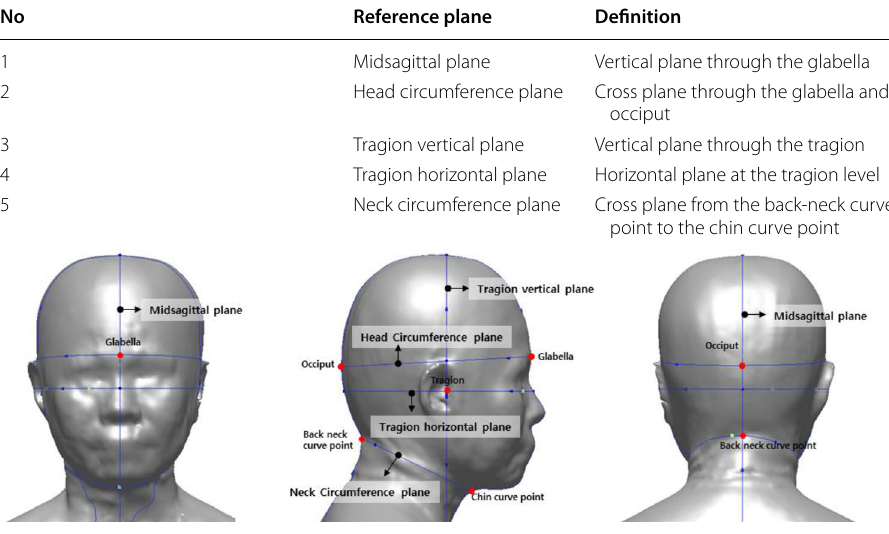
Table 9 Reference planes of the head selected for 3D modeling